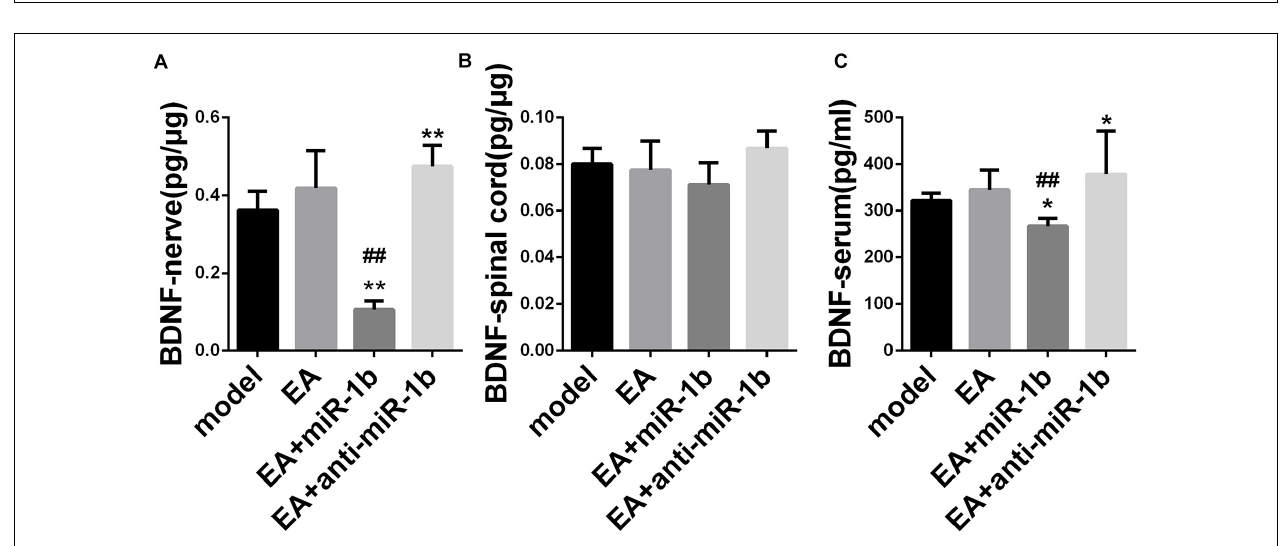
FIGURE 4 | EA promoted sciatic nerve function recovery and SC proliferation through downregulating miR-1b. (A) The recovery rate of NCV was compared among the groups. * P < 0.05 versus the model group. ## P < 0.01 versus the EA group. (B) The recovery rate of SFR was compared among the groups. * P < 0.05 versus the model group. # P < 0.05 versus the EA group. (C) Immunofluorescence staining of S100 in the injured sciatic nerve. Scale bar = 50 µ m. (D) The mean fluorescence density of S100 was analyzed. * P < 0.05 and ** P < 0.01 versus the model group. # P < 0.05 and ## P < 0.01 versus the EA group.